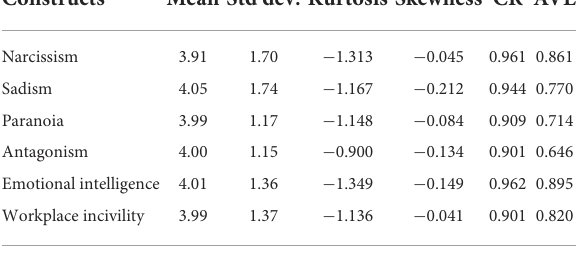
TABLE 2 Descriptive and quality of measurement items.